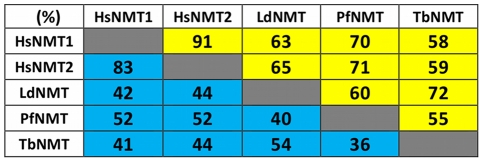
Comparison of protein identity and similarity for the NMT isoforms in this study.Figure showing the percentage sequence identity (Blue) and sequence similarity (Yellow) as defined by BLAST between the NMT proteins from L. donovani (LdonNMT, EMBL accession number FN555136), P. falciparum (PfalNMT, Swiss-Prot Q81LW6), T. brucei (TbNMT, EMBL FN554973) and the catalytic domains of Human NMT isoforms Hs1NMT1 (Swiss-Prot P30419) and Hs2NMT (Swiss-Prot O60551.